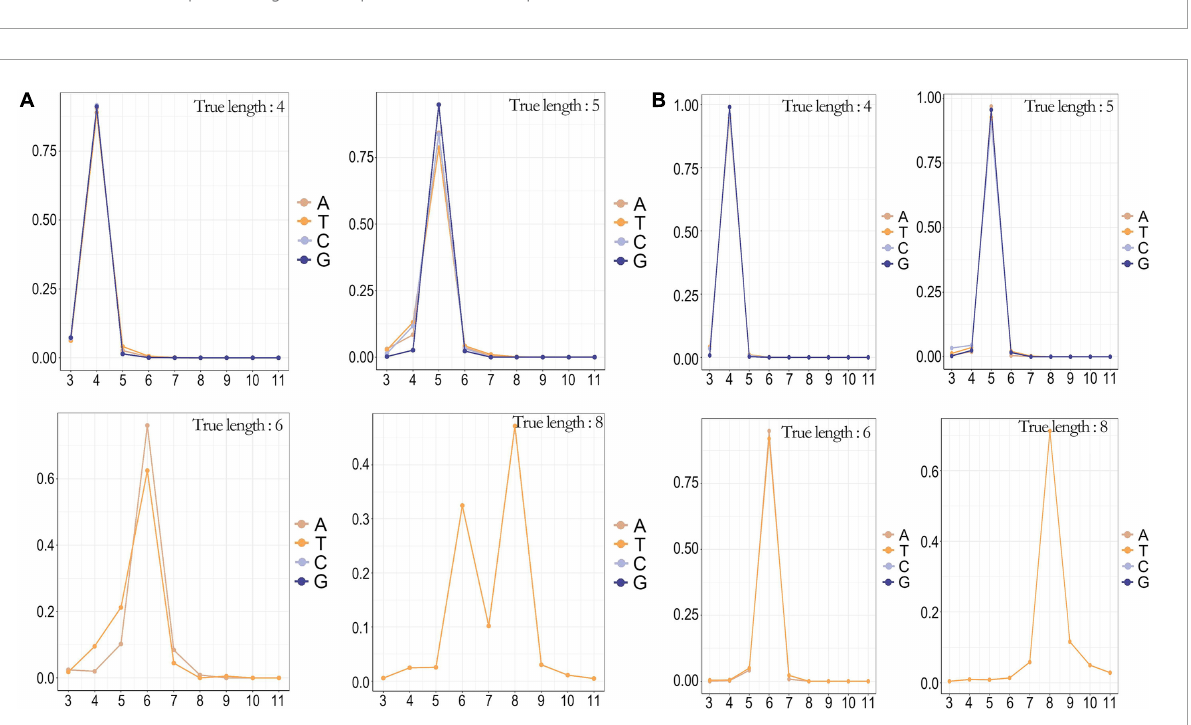
FIGURE4 The counterr density statistic for the detection of different homopolymers on the whole genome of SARS-CoV-2. (A) The counterr density plot of method B in the sup mode for the detection of homopolymer with lengths of 4, 5, 6, and 8; (B) The counterr density plot of method A in the sup mode for the detection of homopolymer with lengths of 4, 5, 6, and 8.